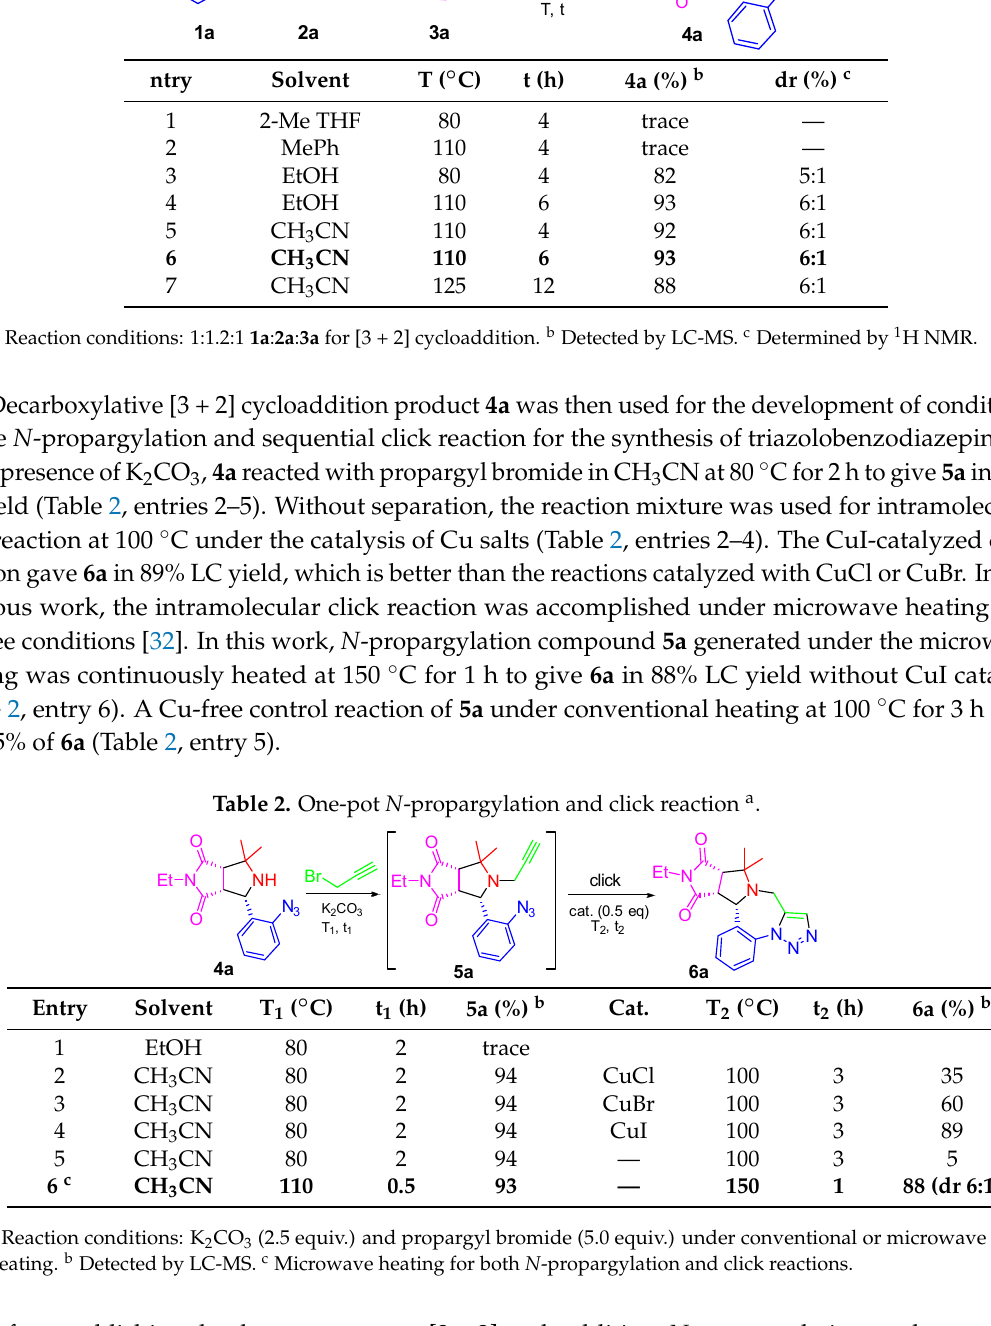
Table 3. Conditions for the one-pot synthesis of 6a a . N